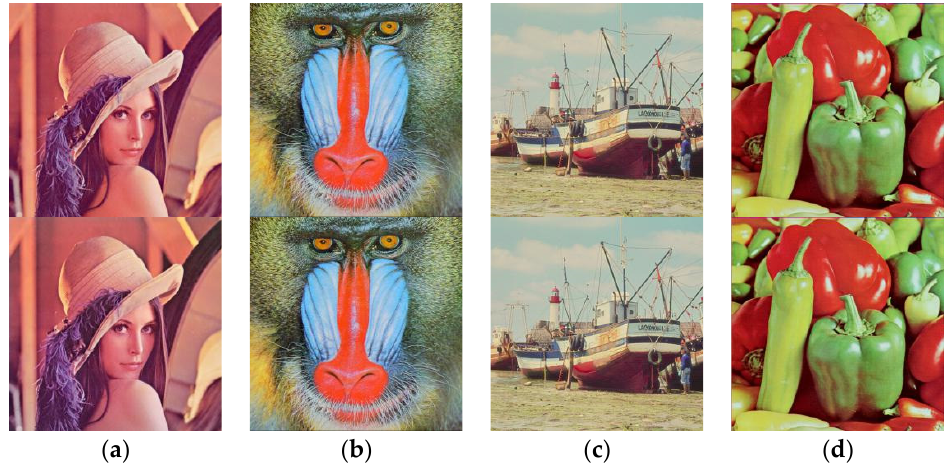
Figure 8. The original images and the corresponding watermarked images by using the proposed embedding algorithm: The first row shows the original images, and the second row shows the corresponding watermarked images, respectively. ( a ) Lena. ( b ) Mandril. ( c ) Boats. ( d ) Peppers